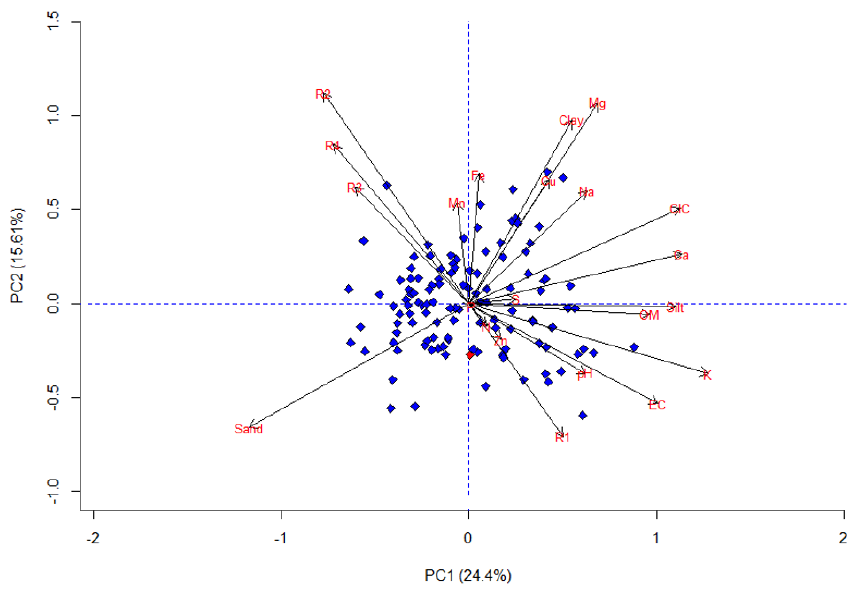
Fig. 4: Principal component analysis. R1= Ca/Mg, R2= Mg/K, R3= Ca/K, R4= (Ca/Mg) K.